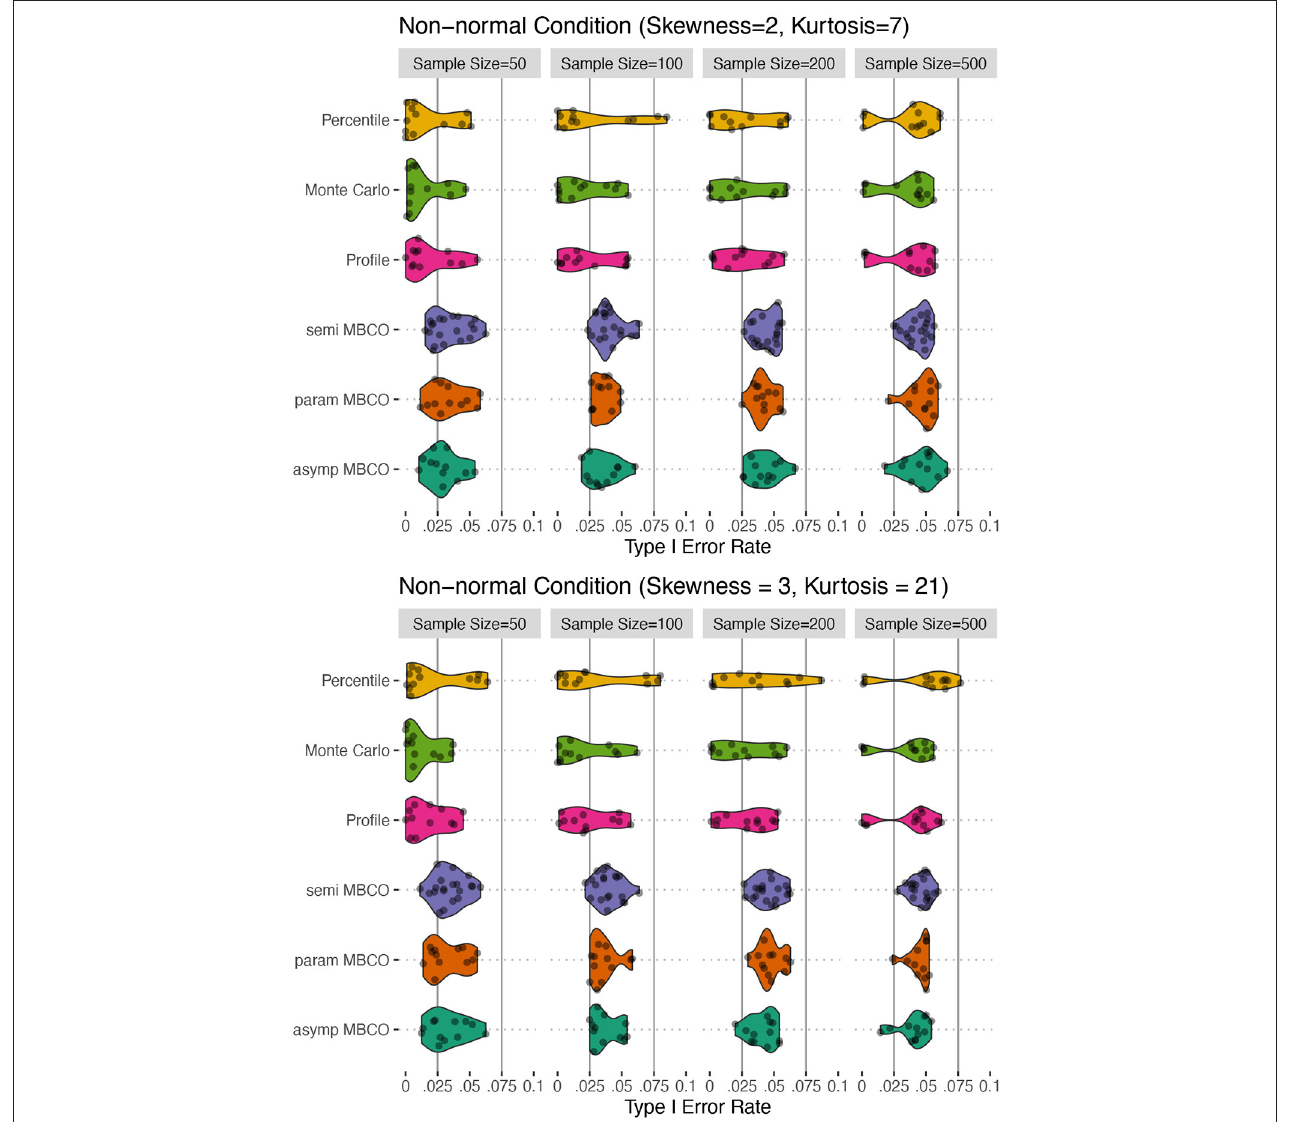
FIGURE 3 | Type I error for non-normality conditions for testing an indirect effect, β 1 β 2 β 3 , in a two-mediator sequential chain. Horizontal solid lines show the limits of Bradley (1978)’s interval of 0.025 and 0.075 for α = 0.05. asymp MBCO, asymptotic MBCO LRT; param MBCO, parametric bootstrap MBCO LRT; semi MBCO, semi-parametric bootstrap MBCO LRT; Profile, Profile-Likelihood CI; Monte Carlo, Monte Carlo CI; Percentile, Percentile non-parametric